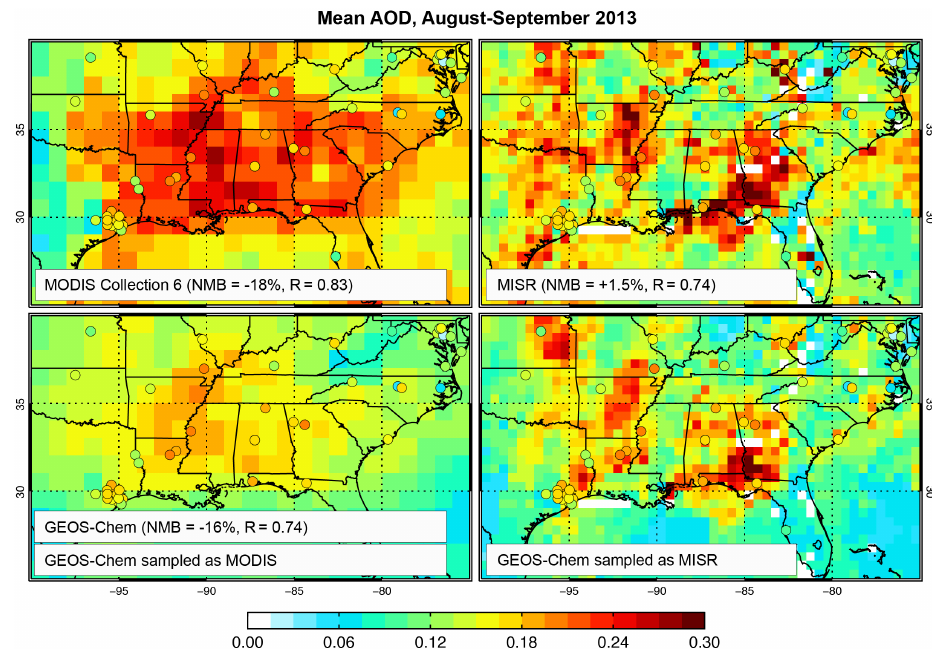
Figure 9. Mean aerosol optical depths (AODs) over the southeast US during SEAC 4 RS (August–September 2013). AERONET data are shown as circles and are the same in all panels. The top panels show MODIS and MISR satellite observations with comparison statistics to AERONET (correlation coefficients, numerical mean biases or NMBs of collocated observations in time and space). The bottom panels show GEOS-Chem model values sampled at the same locations and times as the satellite retrievals. The noise in the MISR panels reflects infrequent sampling (9-day return time, compared to 1-day for MODIS). The negative NMB for the MODIS data reflects occasional retrievals of negative